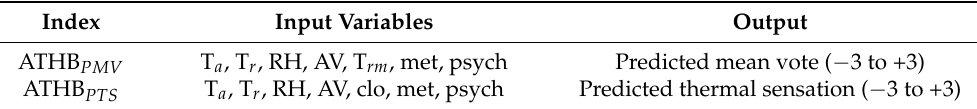
Table 7. Thermal comfort indices using the ATHB model and their input and output variables. T a = air temperature; T r = radiant temperature; RH = relative humidity; AV = air velocity; T rm = outdoor temperature running mean; met = metabolic rate; clo = clothing value; psych = psychological adaptive